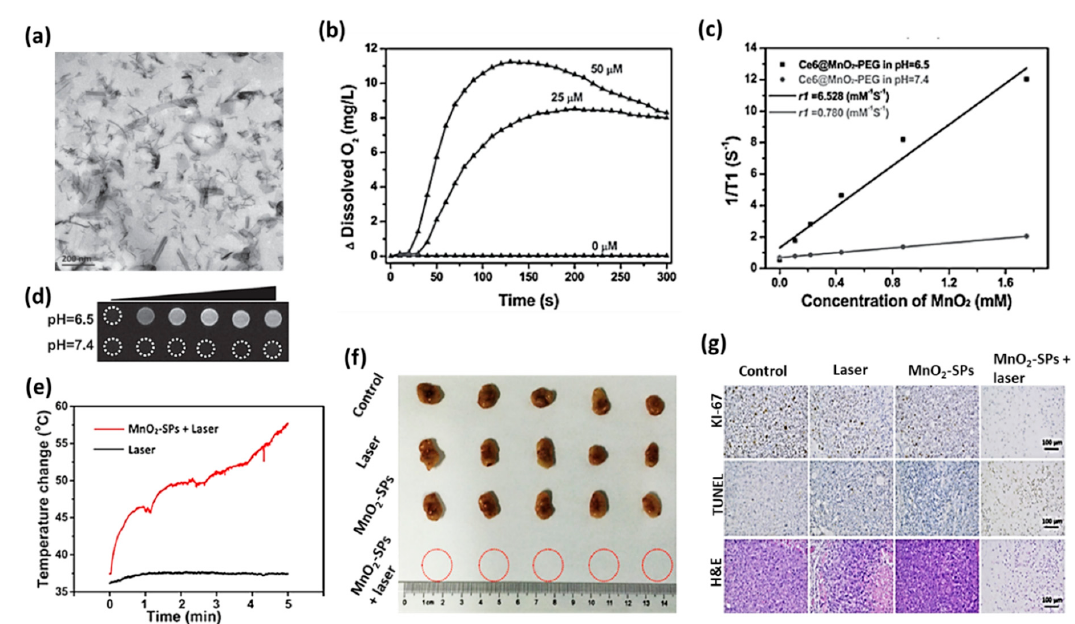
Figure 5. ( a ) Bright-field TEM image of MnO 2 nanosheets with scale bar 200 nm. Adapted with permission from [111]. ( b ) O 2 generation efficacy of MnO 2 nanosheets in H 2 O 2 solution at different concentrations of Ce6@MnO 2 -PEG (0, 25, and 50 μ M). ( c ) The concentration-dependent T 1 relaxation rates and the longitudinal relaxivities (r1) of the composite measured at different pH 7.4 and 6.5. ( d ) T 1 -weighted MR images of various concentrated Ce6@MnO 2 -PEG nanocomposite at different pH values 7.4 and 6.5. Adapted with permission from [103]. ( e ) Increase in temperature observed at the tumor site of BALB/c nude mice bearing 4T1 tumor xenograft during NIR-triggered PTT treatment after intravenous injection of MnO 2 -SPs nanosheets. ( f ) Digital photos of tumors excised from 4T1 tumor-bearing BALB/c nude mice after 16 days of intravenous injection followed by different treatments. ( g ) Tumor tissues of each group after PTT were stained by Antigen Ki-67 immunofluorescence (upper), TUNEL (middle), and H&E (bottom) (Scale bar: 100 μ m). Adapted with permission from [51].